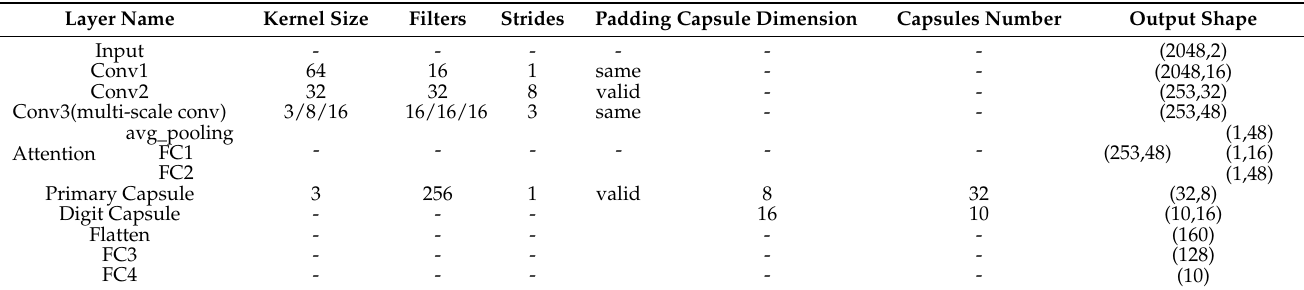
Table 1. MSCAN-JDOT model